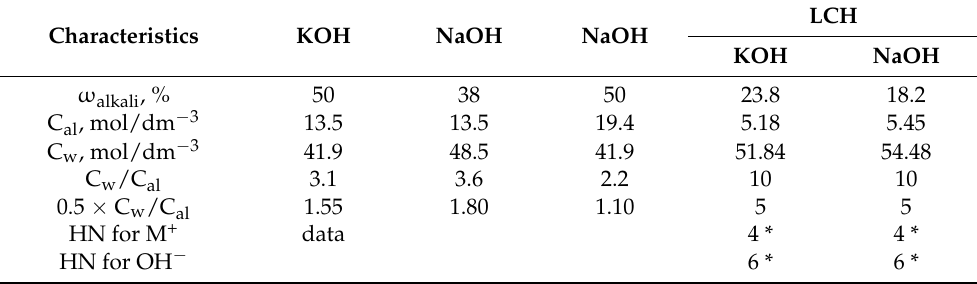
Table 1. Concentrations of NaOH and KOH solutions, calculated values of the number of water